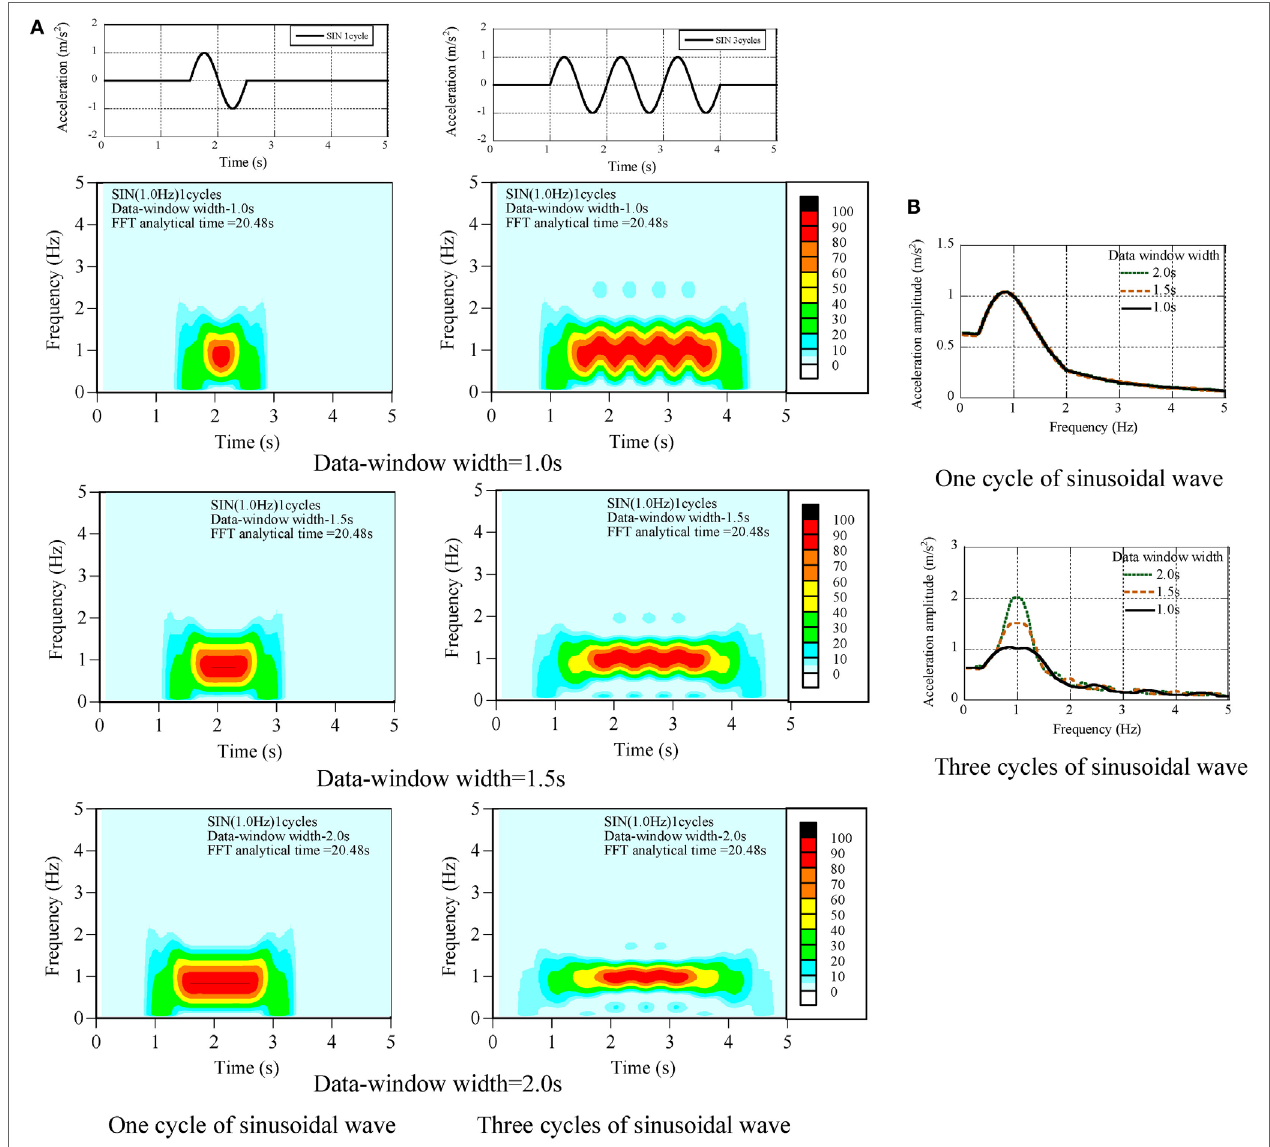
FigUre 2 | Calibration of data-window width, (a) non-stationary Fourier spectra, (b) maximum amplitude spectra.